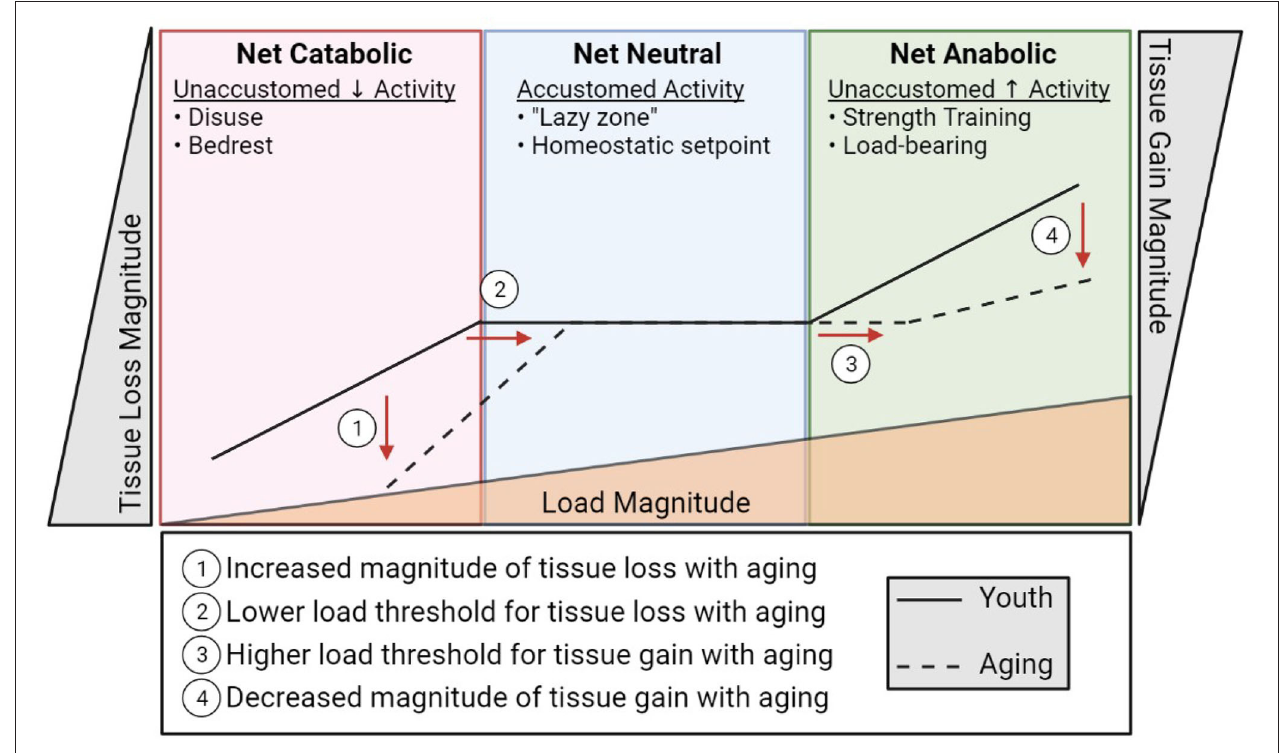
FIGURE 2 | A diagrammatic representation of musculoskeletal catabolic, neutral, and anabolic zones. The solid line represents how load (bottom triangle) influences bone and muscle loss (left), maintenance (center), and creation (right) in youth. The dashed line indicates the apparent shift in load sensitivity (shifted right) and loss/gain magnitude (shifted up/down, respectively) associated with